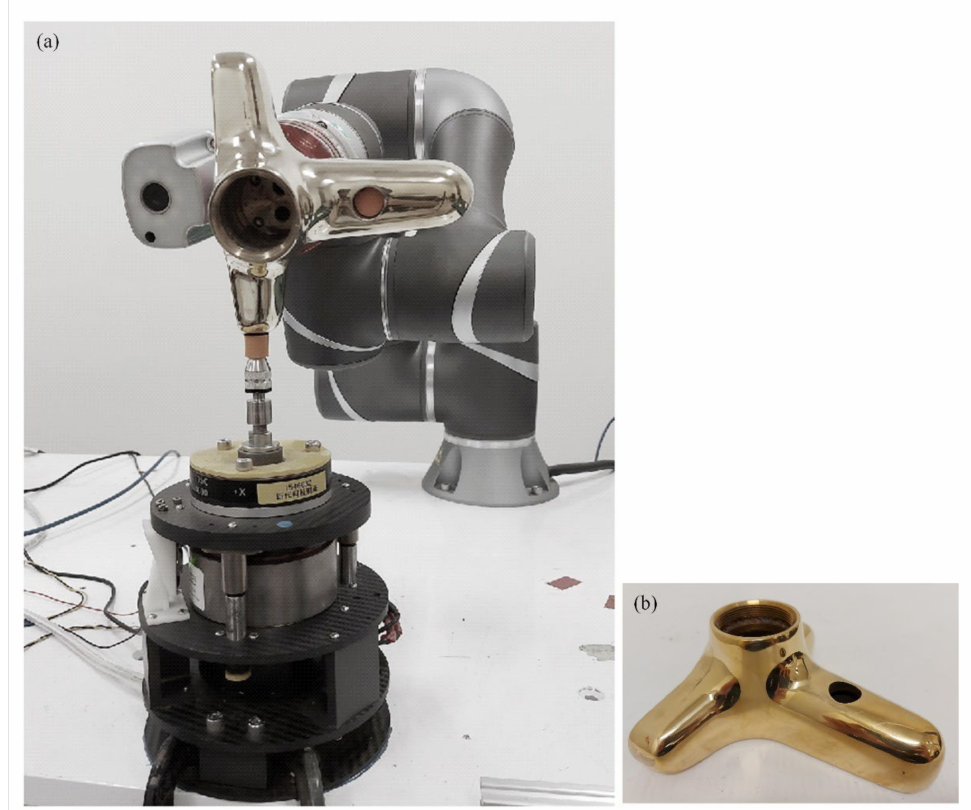
Figure 14. The grinding process ( a ) and the brass faucet ( b